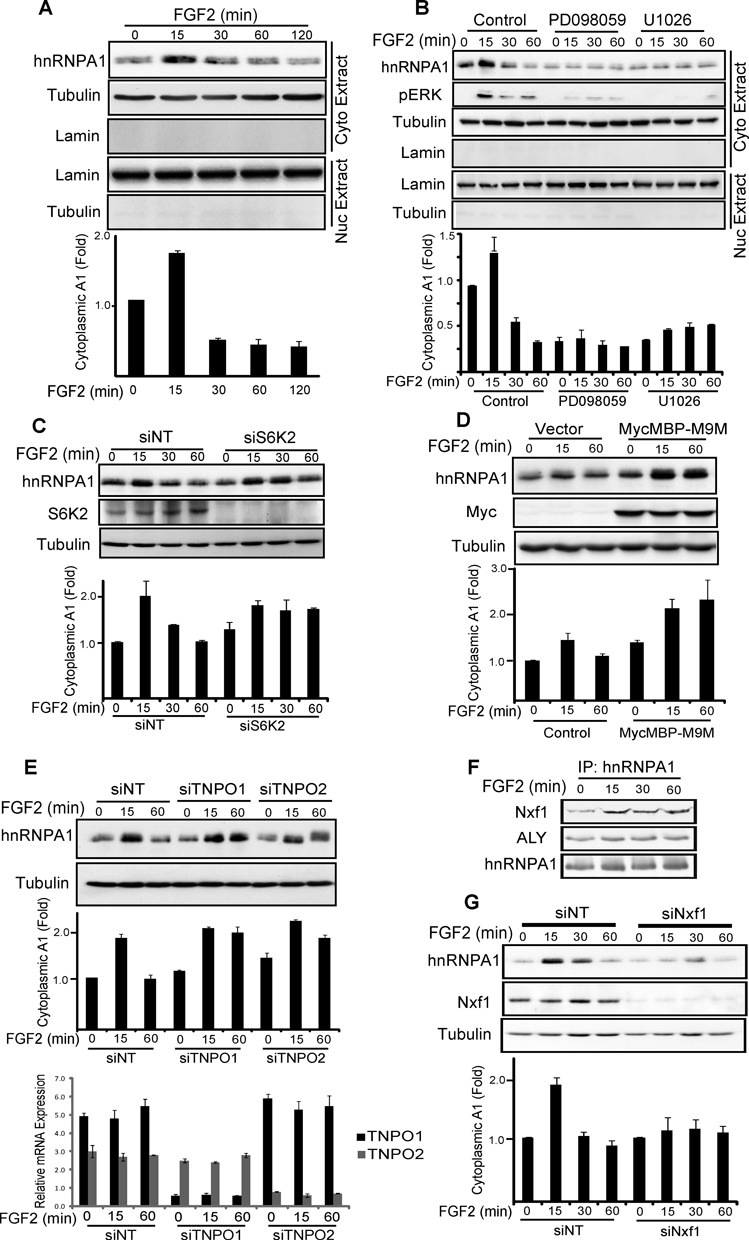
hnRNPA1 shuttles between cytoplasm and nucleus in response to FGF-2. HEK293 cells alone (A), pre-treated with the MEK inhibitors PD098059, U1026 or DMSO alone for 1 h (B), transfected with siRNA for S6K2 (C), TNPO1 and 2 (E) or NXF1 (G) or the karyopherin inhibitor MycMBP-M9M vector or vector alone (D) were treated ± FGF-2 for the indicated time. The cytoplasmic fraction was analysed by SDS-PAGE/western blotting (WB) for the indicated proteins. S6K2 (C), TNPO1 and 2 (E) or NXF1 (G) knockdown were confirmed by SDS-PAGE/WB (C and G) or qPCR (E, lower panel). (A–E and G Lower panel) The hnRNPA1 signal was quantified and normalized to that of tubulin. (F) Endogenous hnRNPA1 was immunoprecipitated from HEK293 cells treated ± FGF-2. Immunoprecipitates were analysed by SDS-PAGE/WB for the indicated proteins. (A–G) Results are representative of at least three independent experiments. Bar graphs are average from replicate experiments ± SEM. See also Supplementary Figure S2.